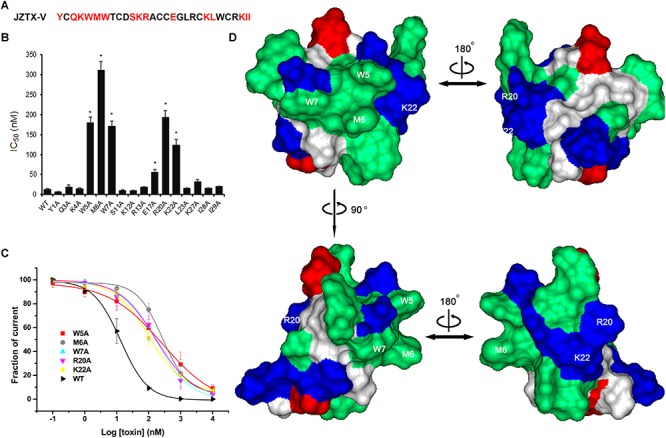
Effects of JZTX-V and analogs on Kv4.2 current. Inhibitory activity of JZTX-V and mutants on Kv4.2 channel. (A) the residues mutated to Ala are shaded in red. (B) IC50 values on Kv4.2 channel of JZTX-V and analogs. (C) concentration dependence for the inhibition of five JZTX-V mutants (W5A, M6A, W7A, R20A, and K22A) on Kv4.2. (D) bioactive surface profile of JZTX-V binding to Kv4.2. The left and right structures were rotated 180° relative to one another about a vertical axis. *P < 0.05 compared with WT group.